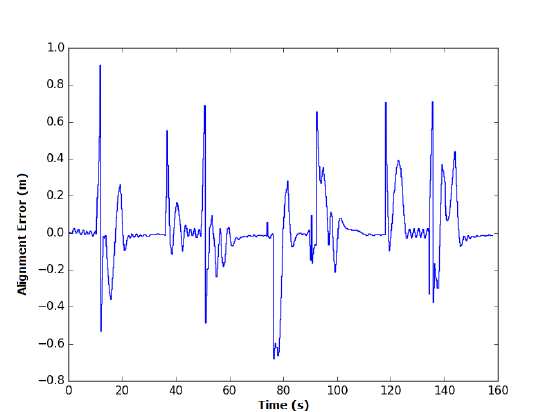
Figure 24. Variation in the alignment error of the robot in the course of experiment 2 in Supervisory